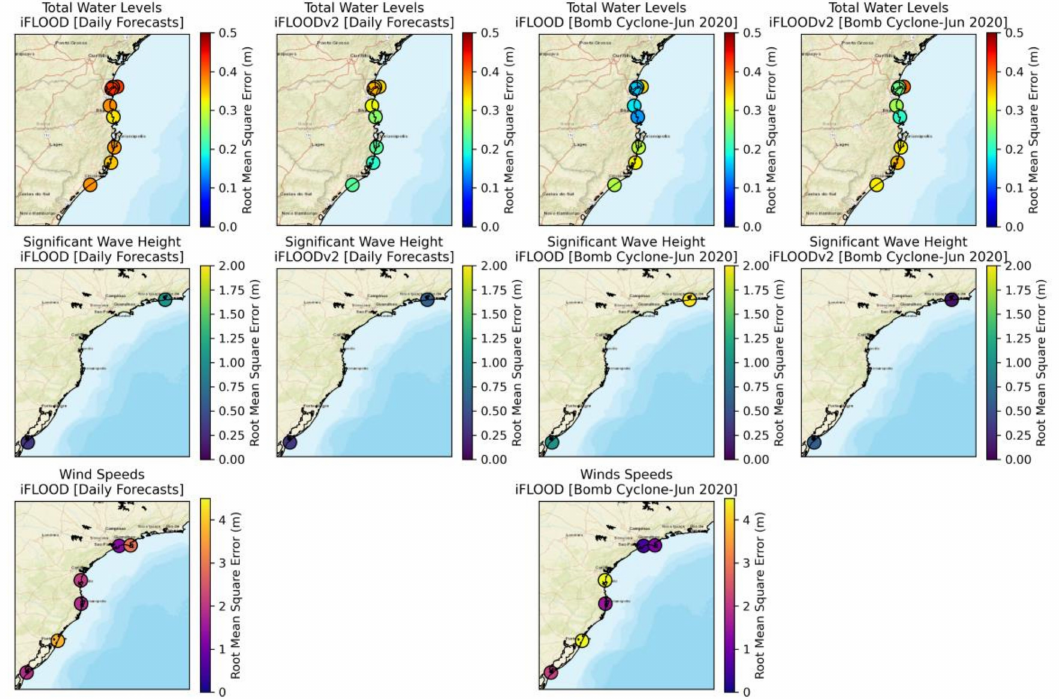
Figure 11. Spatial distribution of the computed RMSE values for forecasted products from iFLOOD and bias-corrected iFLOODv2 models at various recording stations during daily and extreme weather in